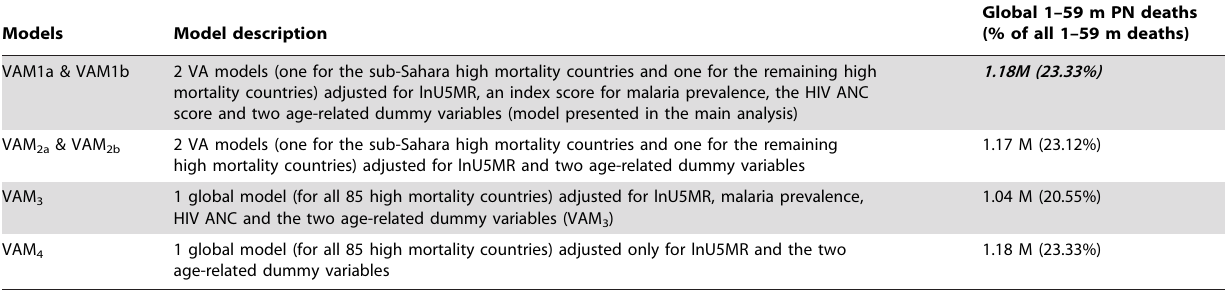
Table 5. Sensitivity analysis for the global post-neonatal pneumonia estimates based on the application of alternative verbal autopsy models (VAM) for the high mortality countries (Number of pneumonia deaths for low mortality countries and for India and China are estimated in the same way among all four different approaches; VAM1a & VAM1b are the models presented in the main analysis; PN: Pneumonia; lnU5MR: Natural logarithm of the under 5 mortality rate; HIV ANC: index score for HIV prevalence based on the antenatal care